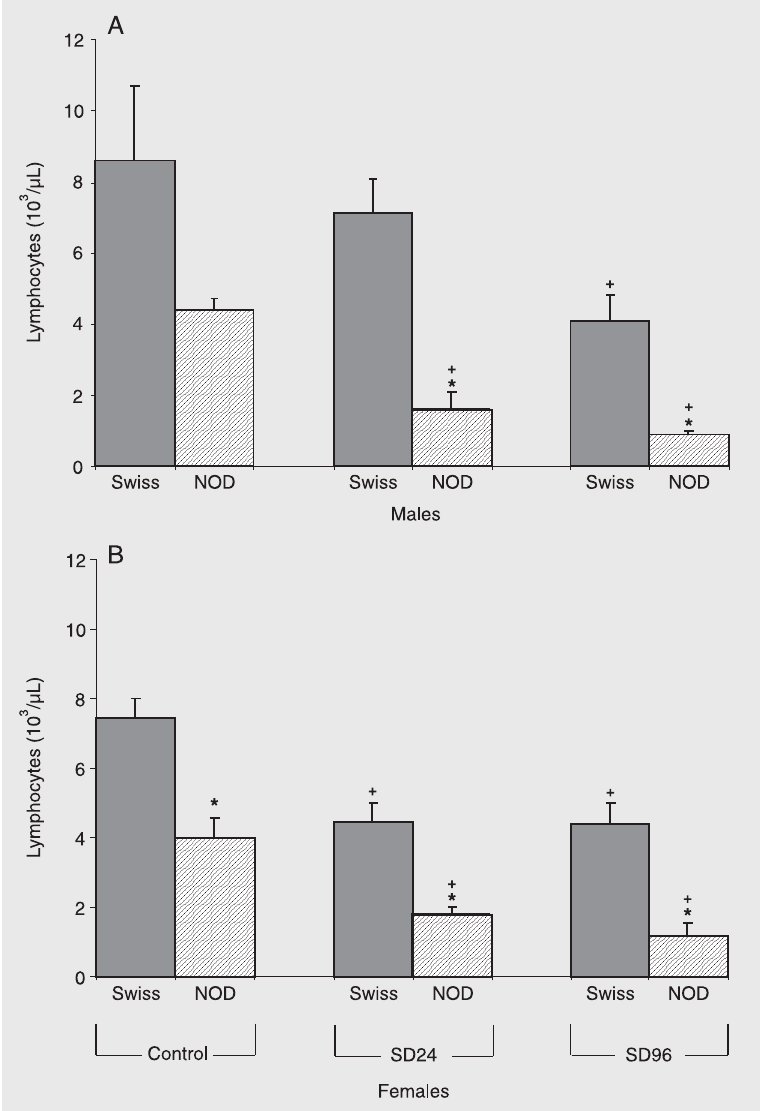
Figure 1. Effect of sleep deprivation for 24 and 96 h on the lymphocyte count of male (panel A) and female (panel B) non-obese diabetic (NOD) and Swiss strain mice submitted to sleep deprivation for 24 (SD24) and 96 h (SD96) or maintained as home-cage control. Data are reported as means ± SEM for 4-8 animals per group. *P < 0.05 compared to Swiss mice; + P < 0.05 compared to the control group of each strain (Student t